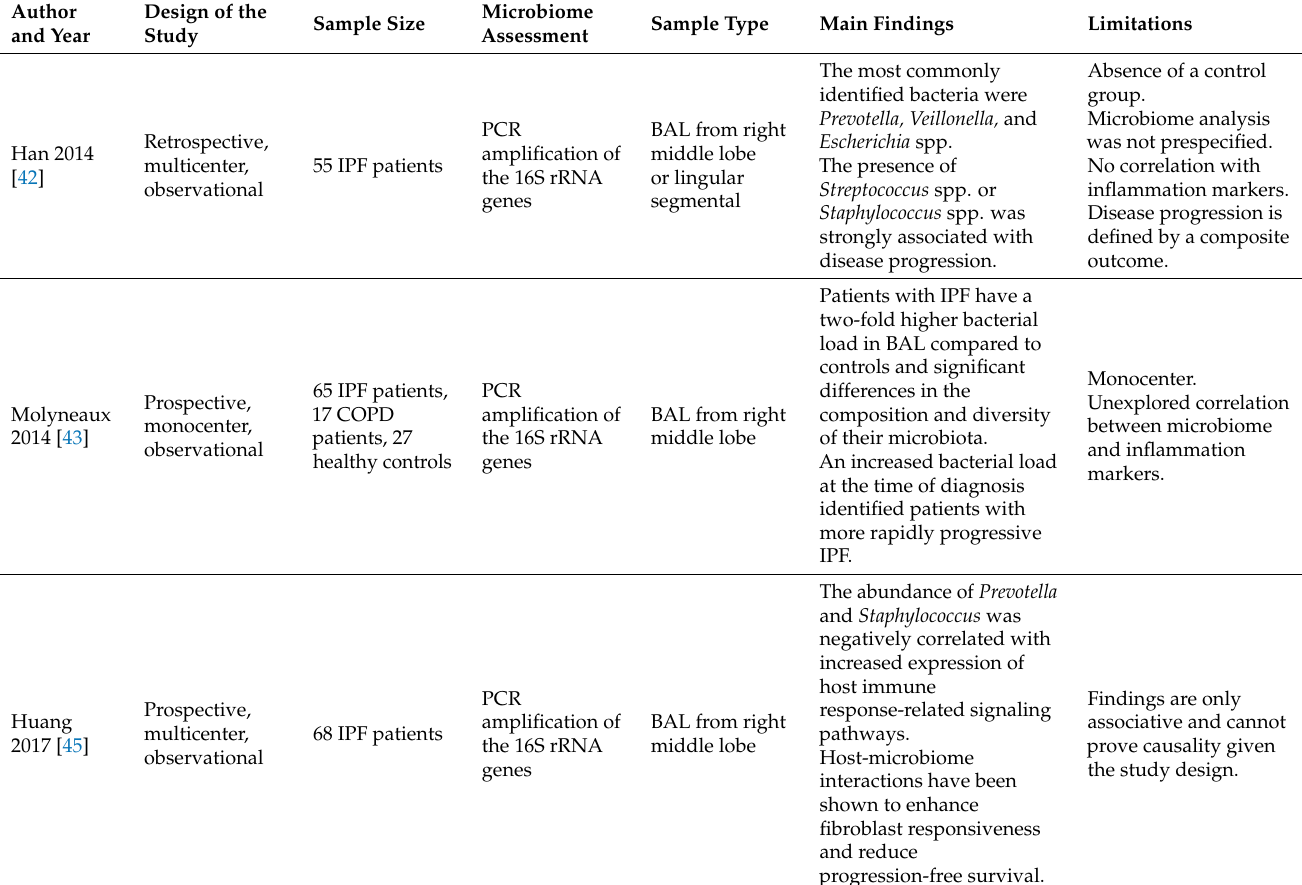
Table 2. Studies investigating the role of microbiota in development and progression of IPF using non-culture-dependent